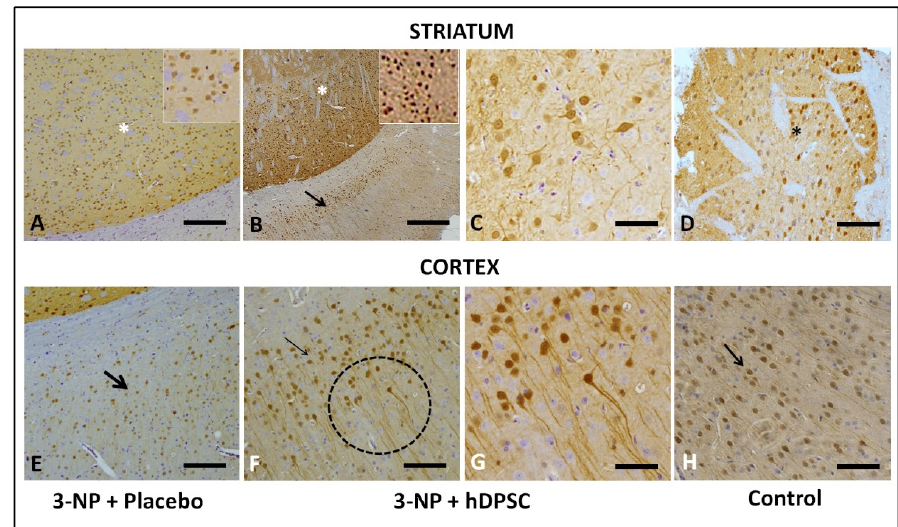
Figure 6. Expression of the anti-DARPP32 antibody in the striatum ( A – D ) and cortex ( E – H ) in 3-NP + Placebo ( A , E ), 3-NP + hIDPSC ( B , C , F , G ) and in control ( D , H ) animals, respectively. Black arrows indicate anti-DARPP32 expressing cells. ( C , G ) demonstrate high magnification of ( B , F ). Sections are contra stained with HE. Scale bars: 50 μ m ( A , B , E , F ), 25 μ m ( C , G ) 10 μ m ( D , H ). Analysis performed 30 days after the treatments (D35). Asterisk indicates the enlarged areas.